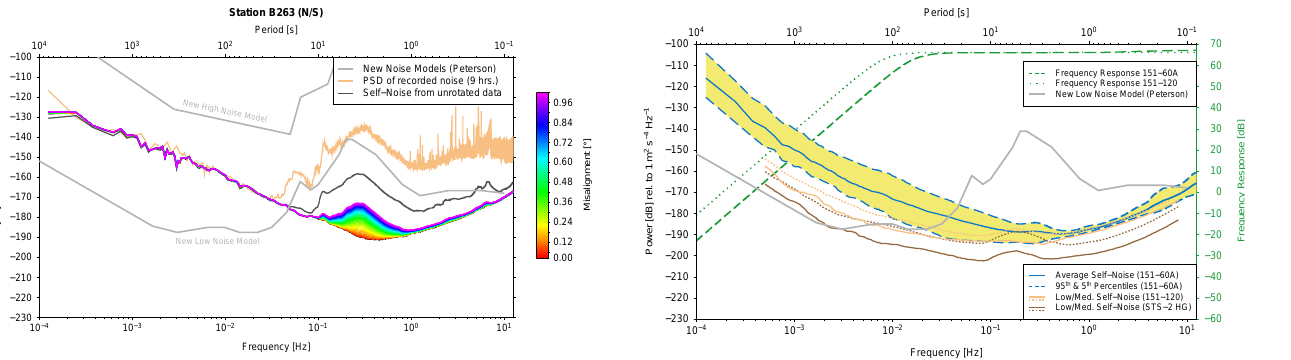
Fig. 6. Self-noise model for the RefTek 151-60A calculated from data (9h) recorded at the Conrad Observatory by 15 collocated sensors. Self-noise was computed for all possible permutations of triples of sensors (vertical components only). From the results, 306 self-noise curves of 13 sensors were selected for derivation of this model. To best estimate the instrument’s true self-noise, curves of clearly misaligned triples of sensors were